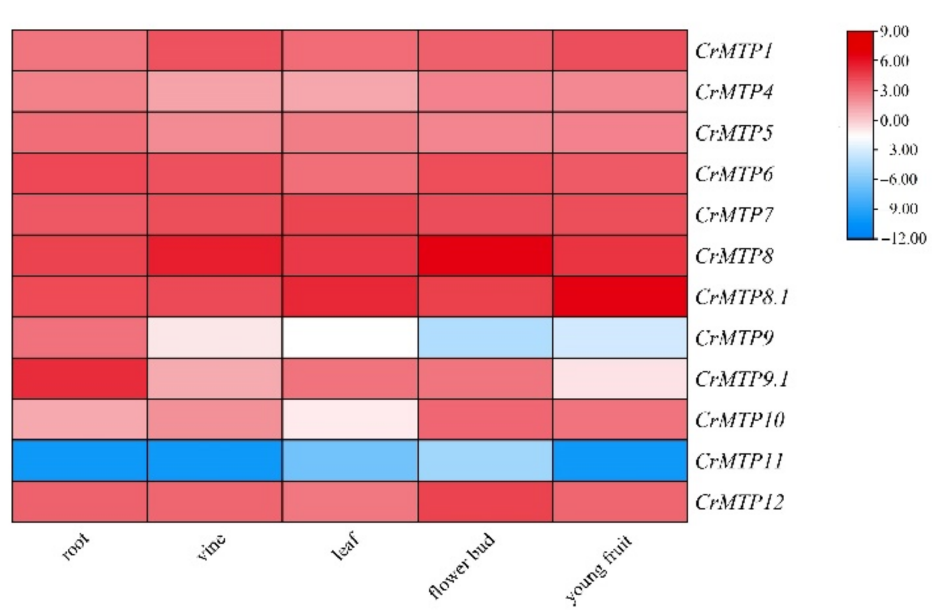
Figure 7, eight genes ( CrMTP1 , 4 , 5 , 6 , 7 , 8 , 8.1 , and 12 ) were highly expressed in all five tissues. The expression levels of the other members ( CrMTP9 , 9.1 , 10 , and 11 ) varied among these tissues.